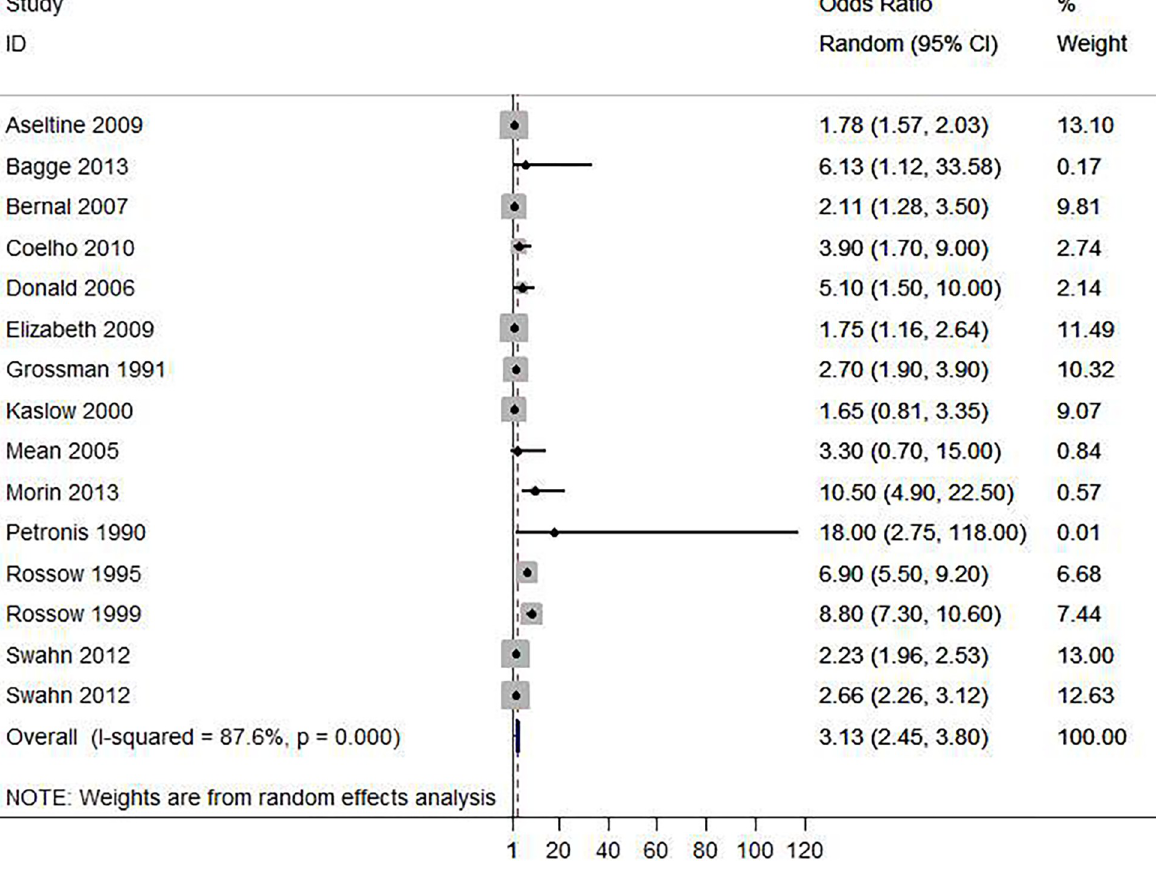
Fig 3. Forest plot of the association between alcohol use disorder and suicide attempt.